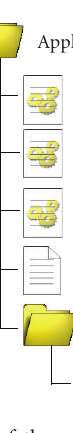
Figure 2: Example of the organization of interactive application